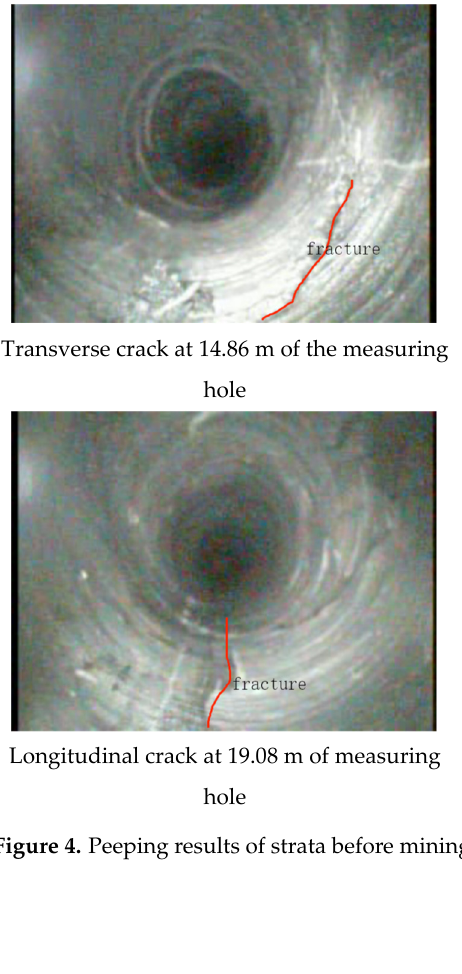
Figure 3. Peeping results of strata after mining in No. 1 hole 15 m away from the working face.